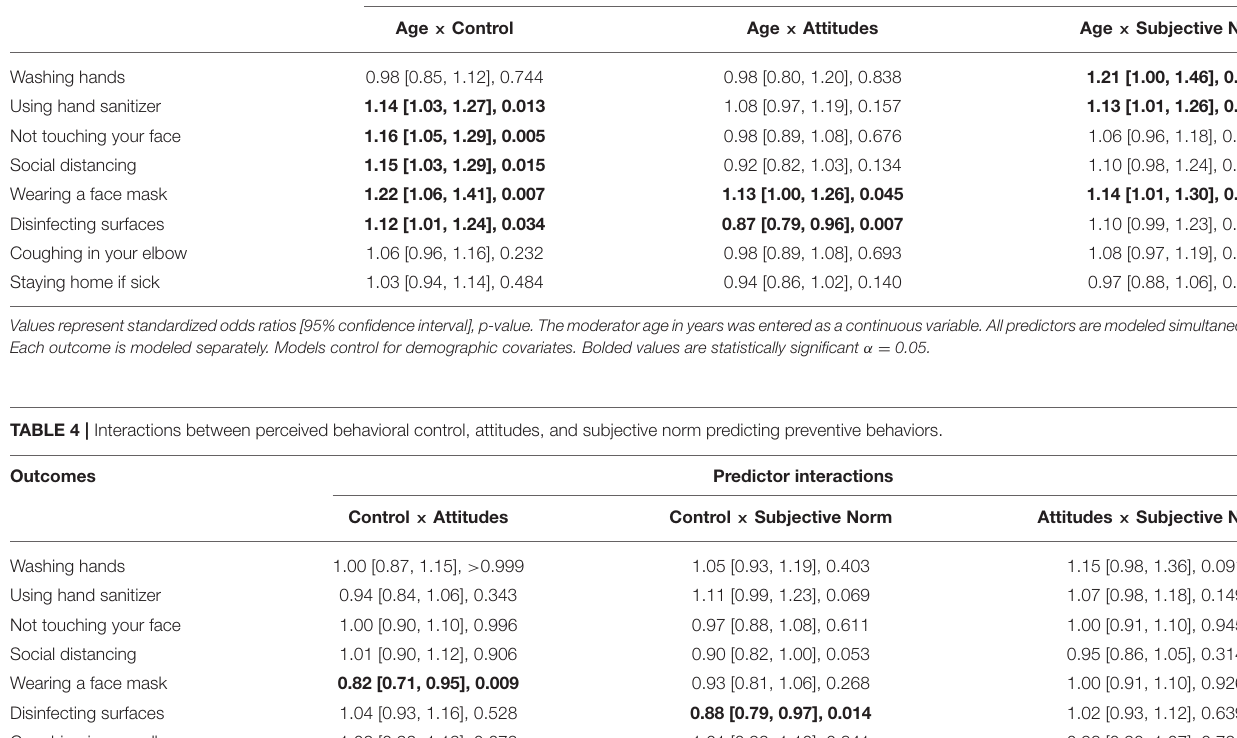
Values represent standardized odds ratios [95% confidence interval], p-value. All predictors are modeled simultaneously. Each outcome is modeled separately. Models control for demographic covariates. Bolded values are statistically significant α =